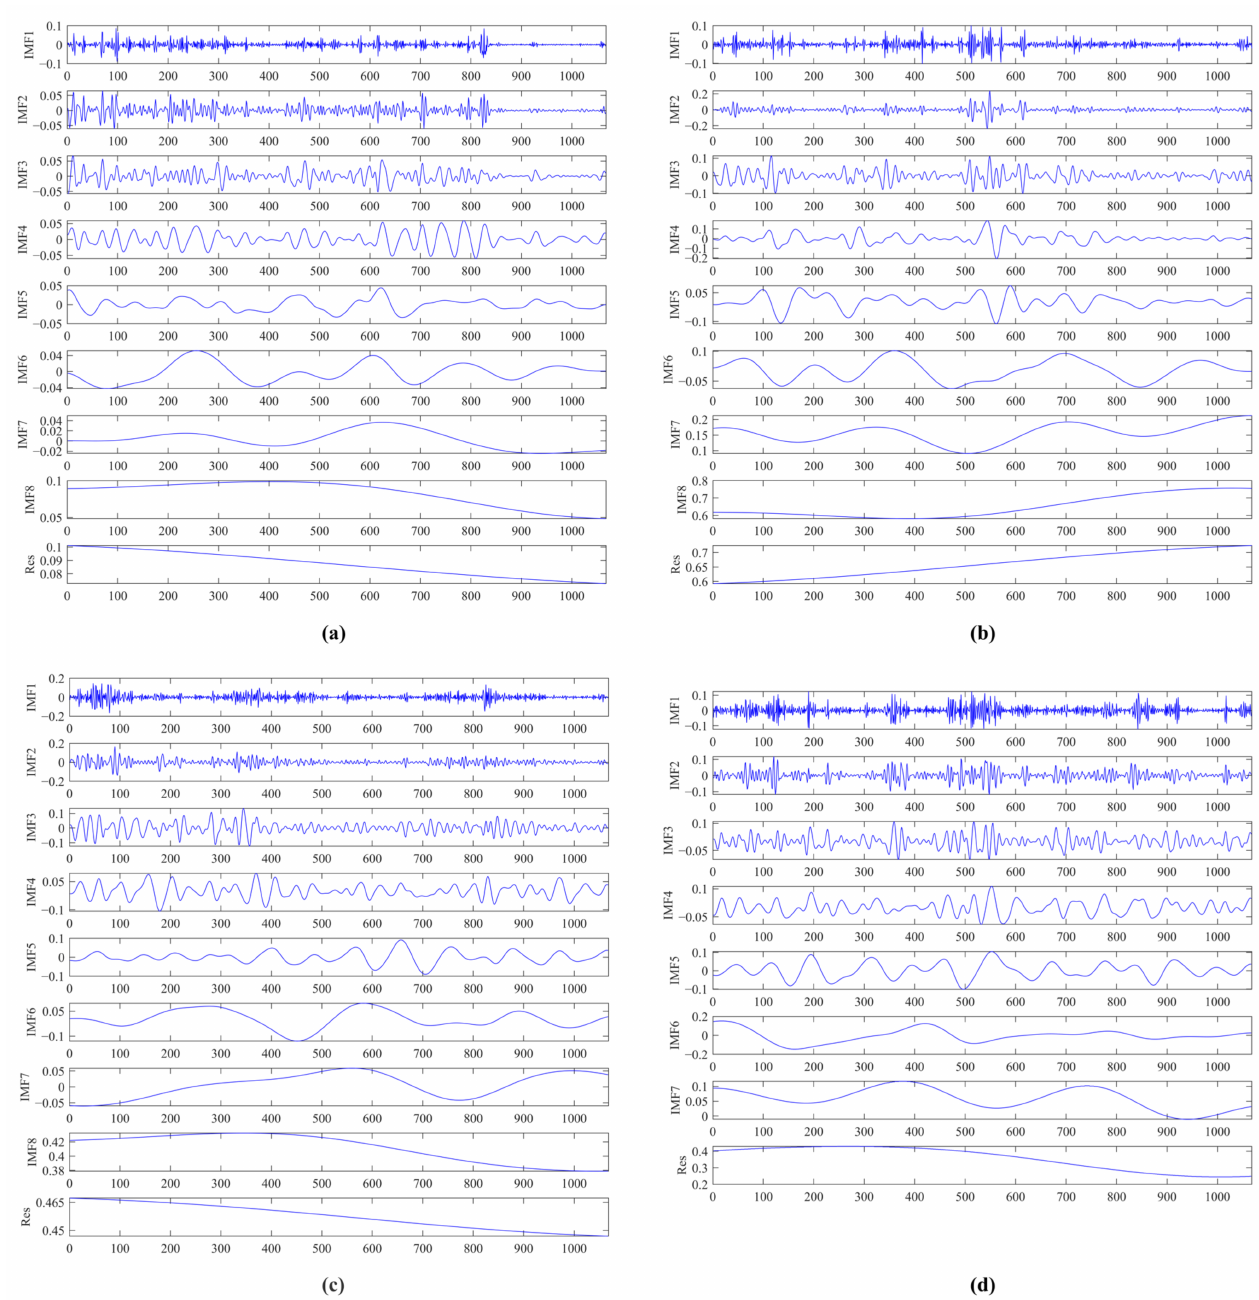
Figure 6. Decomposition results of the ( a ) NH 3 -N, ( b ) pH, ( c ) DO, and ( d ) COD Mn time